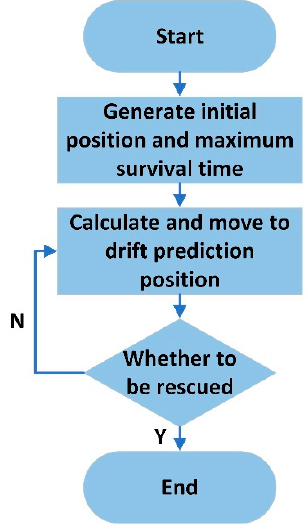
Figure 10. The behavior model of the PDT agent.